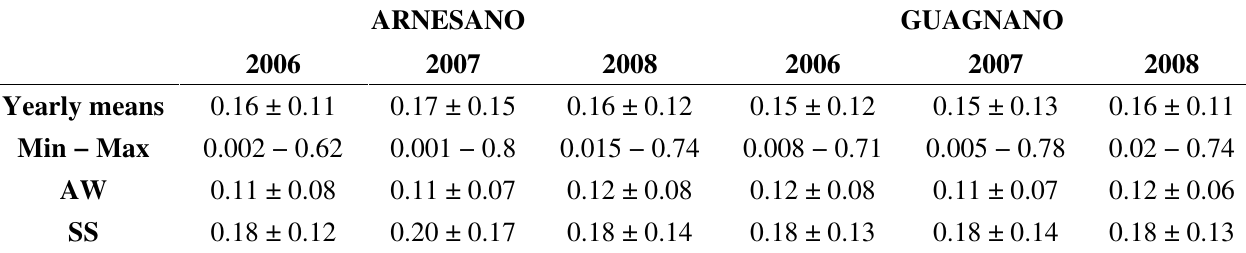
Table 2. Yearly means, minimum (Min), maximum (Max), autumn–winter (AW), and spring-summer (SS) mean values ± 1 SD deviation of MODIS AOTs at Arnesano and Guagnano from 2006 to